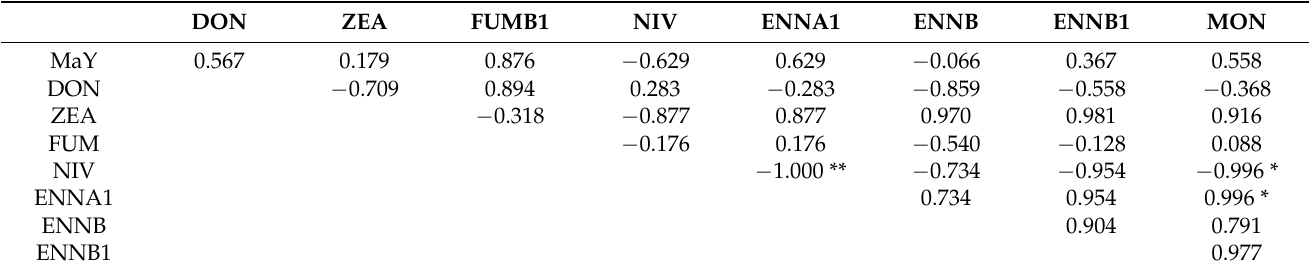
Table 7. Mold and yeast population and mycotoxin Pearson’s correlation